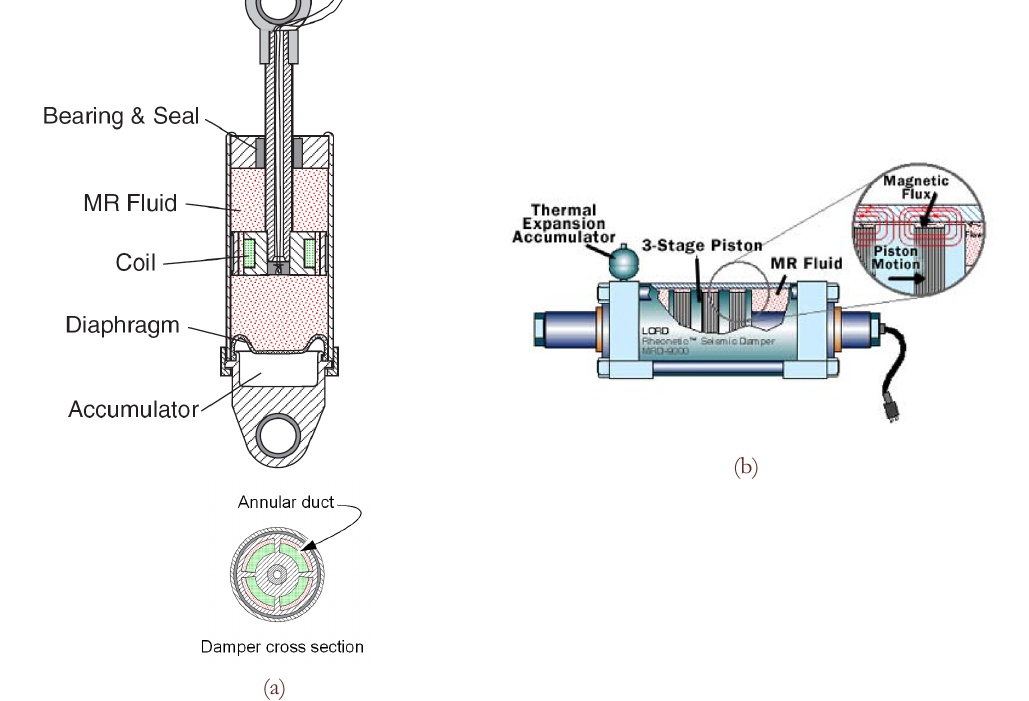
Figure 5: Schematic of single ended MR damper and double ended MR damper, both produced by Lord